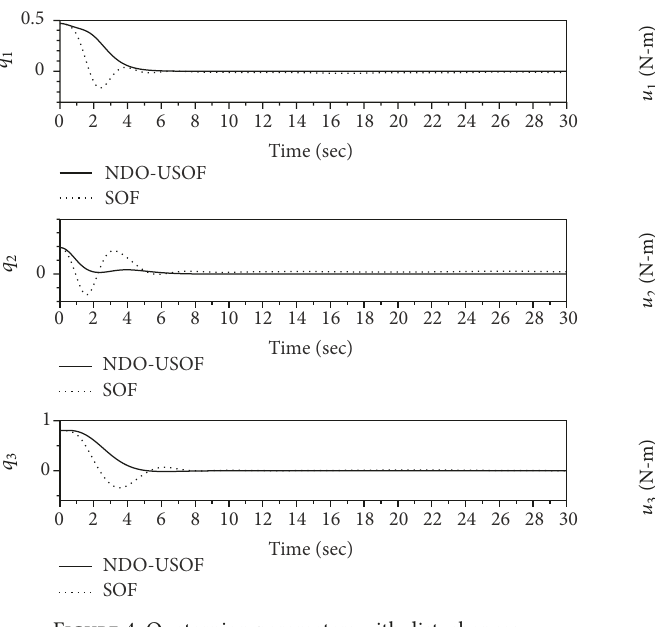
Figure 4: Quaternion parameters with disturbances.